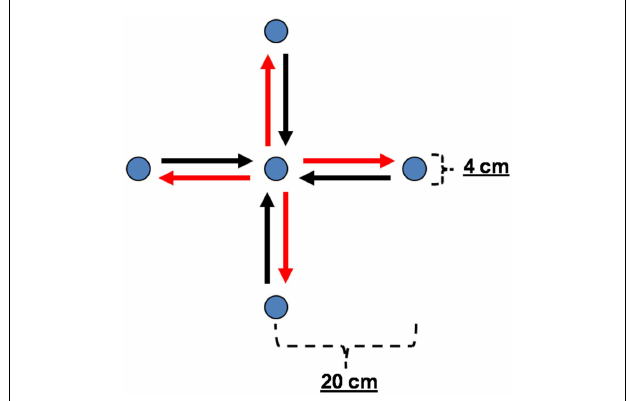
FIGURE 1 | Experimental paradigm. Sketch of the center-out/center-in arm movement task with arrows representing the eight movement classes used for the analyses, i.e., four center-out (red) and four center-in (black) movements.Targets consisted of buttons with a diameter of 4cm mounted on a table. Inter-button distances were